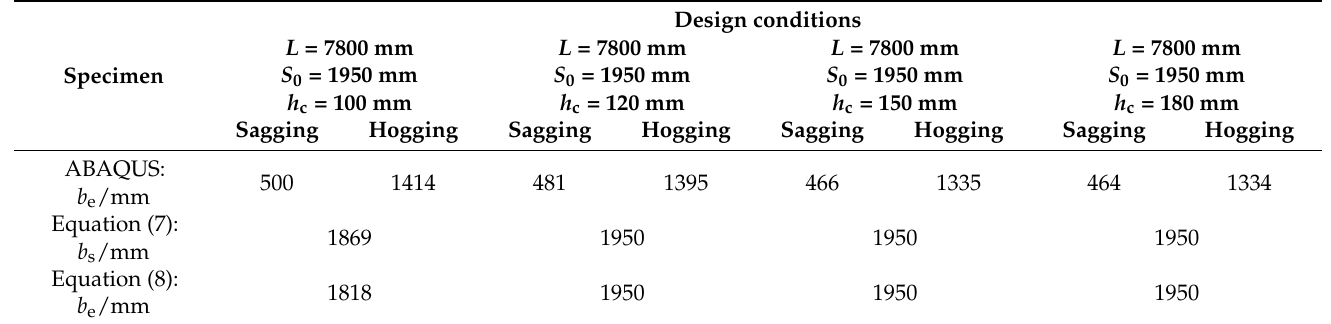
Table 6. The effective slab width under changing slab thickness h c